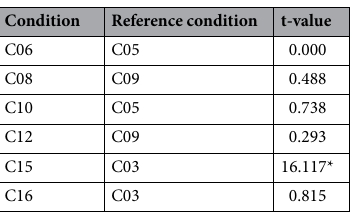
Table 3. t-Test table: results of reference noise condition and increasing watermarking strength. Statistically important differences ( α = 0.05 critical value 1.662) are marked with * character.